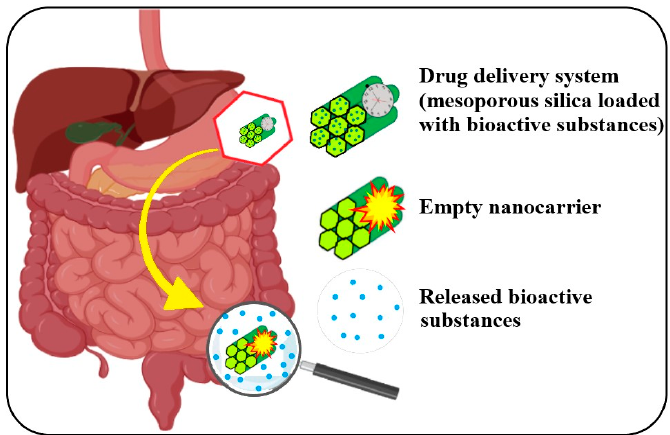
Figure 7. Digestive system disease treatment with mesoporous silica loaded with bioactive substances (realized with BioRender.com; accessed on 15th February 2023) [156,160,161].